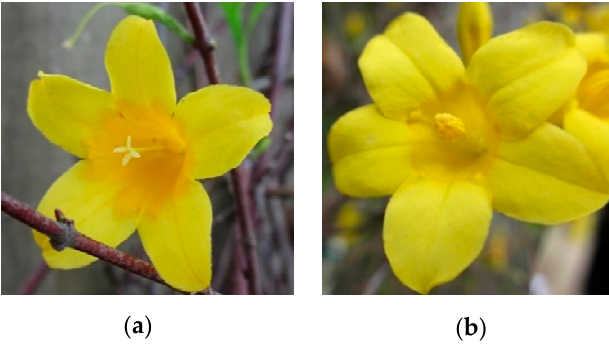
Figure 1. Gelsemium sempervirens flowers: ( a ) L -styled pin morph and ( b ) S -styled thrum morph.